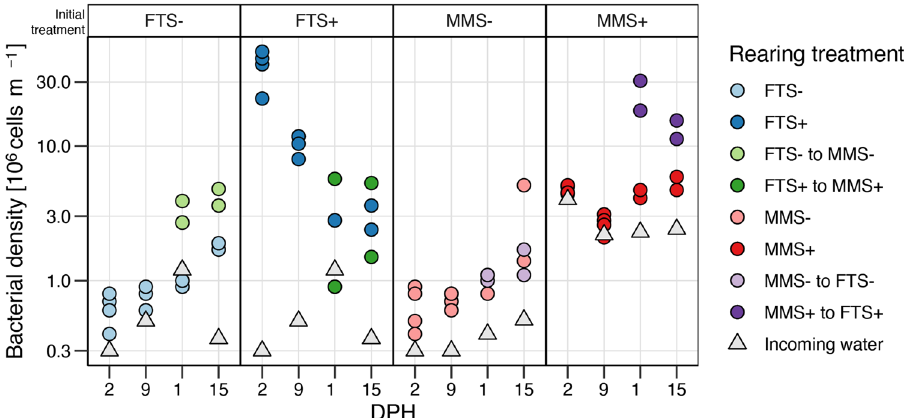
Figure 1. Bacterial density (million bacterial cells mL −1 ) at various days post-hatching (DPH) in incoming and rearing tank water. Note that the y-axis is log scaled. Colours indicate the rearing treatment, and shape signifies rearing (filled circle) and incoming water (filled